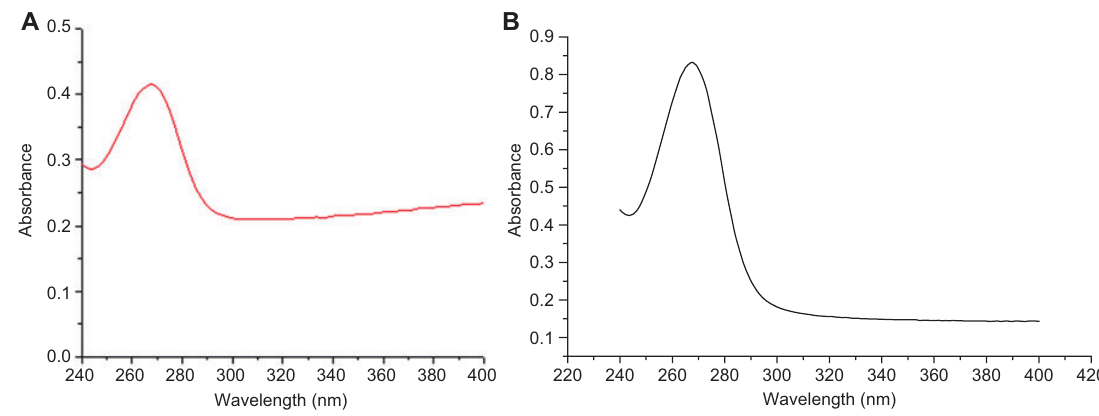
Figure 5 Absorption spectra of: (A) (4) ; and (B) after sintering (4) at 150 ° C for ∼ 10